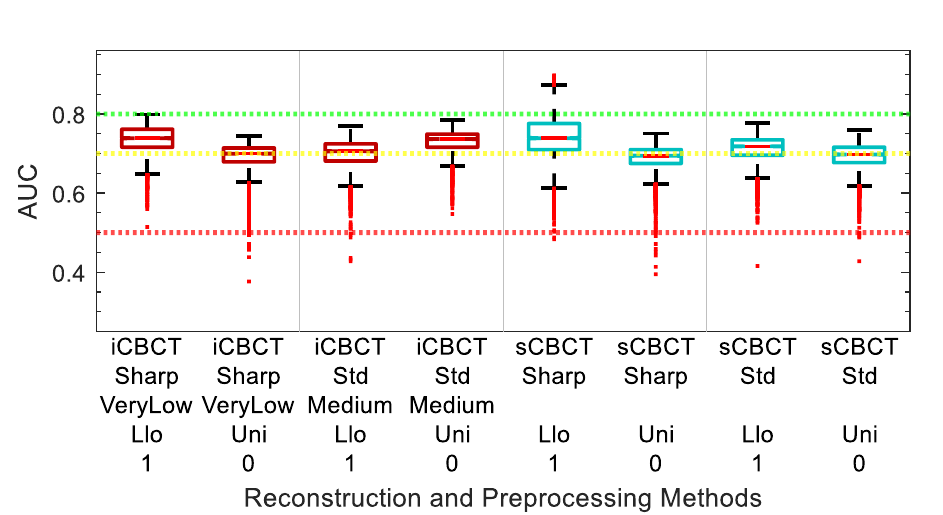
Figure 9. ∆IPSS AUC of delta-radiomic models vs Reconstruction and Preprocessing methods. The AUC collected over 1000 iterations of the leave-one analysis and over all BED bins.